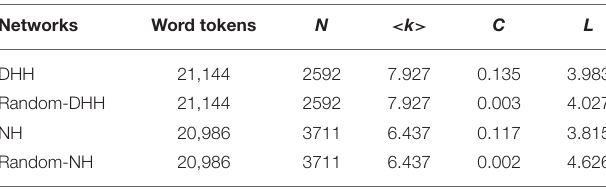
TABLE 3 | Major measures of the two networks and those of their corresponding random networks. Networks